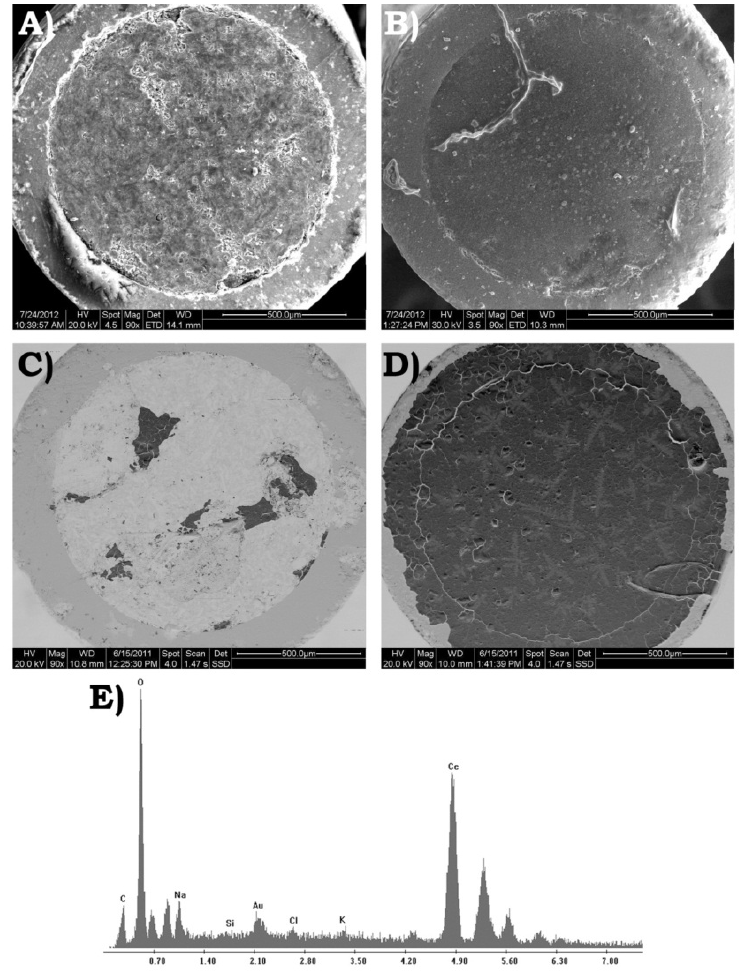
Figure 10. SEM micrographs and example of EDS corresponding to different (25% w/w)- configurations of the SNGC electrodes used and not used: AuSNPs/CeO 2 modified SNGC electrode ( A ) used and ( B ) not used, both obtained with the secondary electron detector; AuSNPs/CeO (2.5% w/w)-modified SNGC electrode ( C ) used and 2 ( D ) not used, both obtained with the backscattered electron detector; ( E ) X-ray EDS nanocomposite film deposited on the surface of a corresponding to the AuSNPs/CeO 2 SNGC electrode. All the micrographs were obtained at the magnification of 90× and operating in the range of 24–30